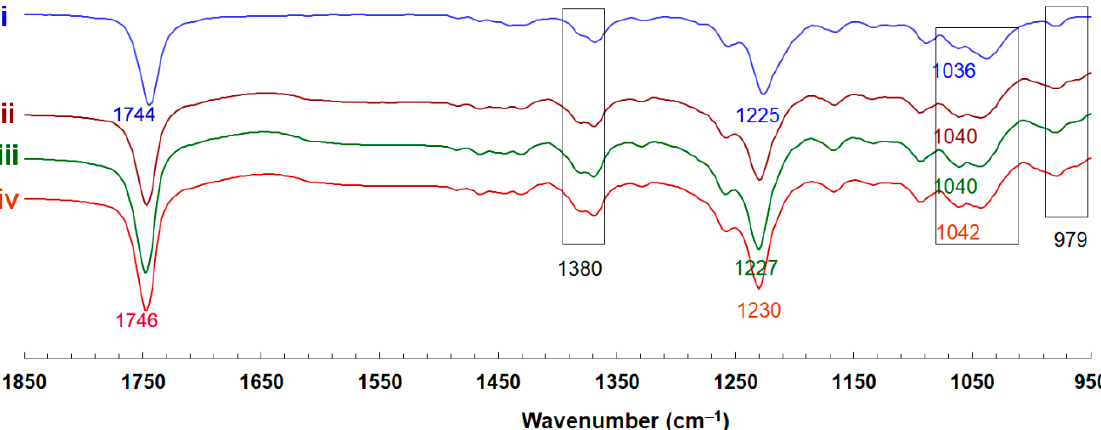
Figure 8. Overlay of the IR spectra of gelator 7a as solid (i), the gels formed by the compound 7a in DMSO:H 2 O ( v/v 1:2) at 6.0 mg/mL for ii–iv. (ii) the gel of compound 7a without any metal salt; (iii) the metallogels of compound 7a with Ni(OAc) 2 · 4H 2 O (1.5 equiv of 7a ); (iv) the metallogels of compound 7a with Zn(OAc) 2 · 2H 2 O (1.5 equiv of 7a ).